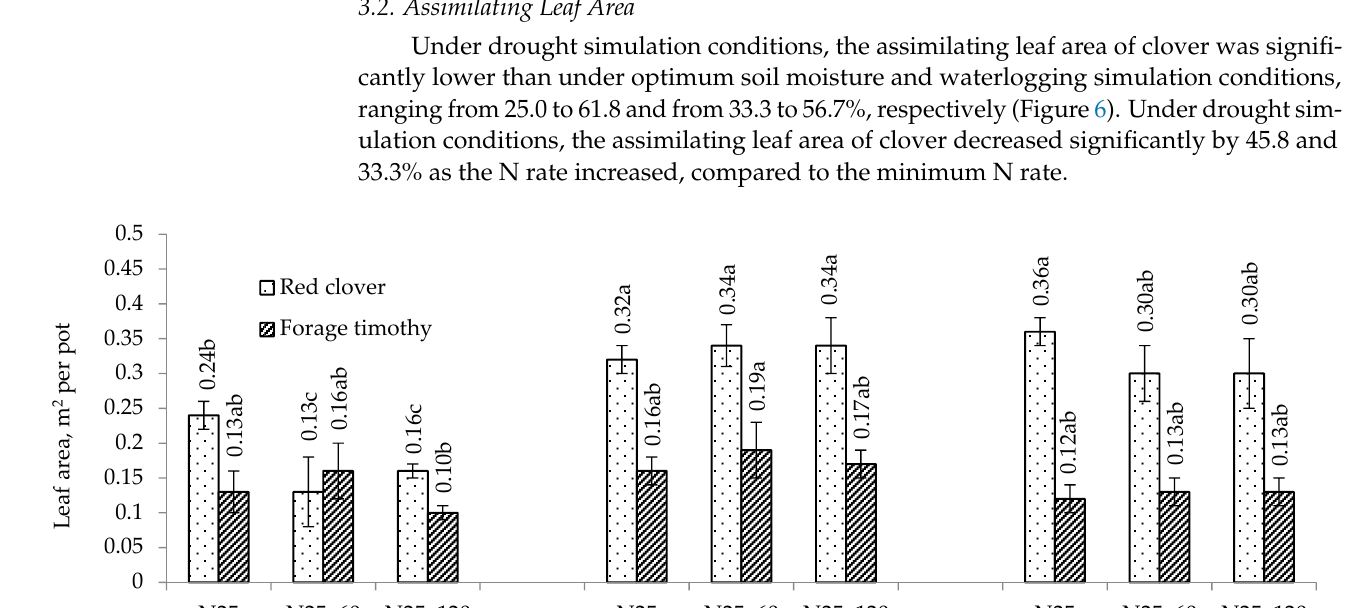
Figure 5. Growing dynamics of forage timothy. Note, whiskers indicate standard errors of the means.